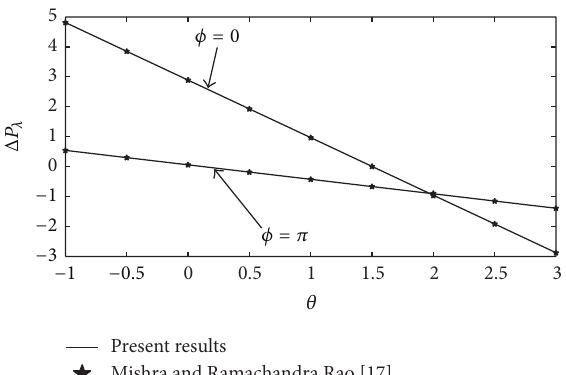
Figure 2: Comparison of pressure rise Δ𝑃 𝜆 against flow rate 𝜃 with Mishra and Ramachandra Rao’s results [17] when 𝑑 = 2 , 𝑎 = 0.7 , 𝑏 = 1.2 , = 0 , 𝑛 = 1 , Gr = 0 , and 𝑁 = 0 . 𝑏 𝑠